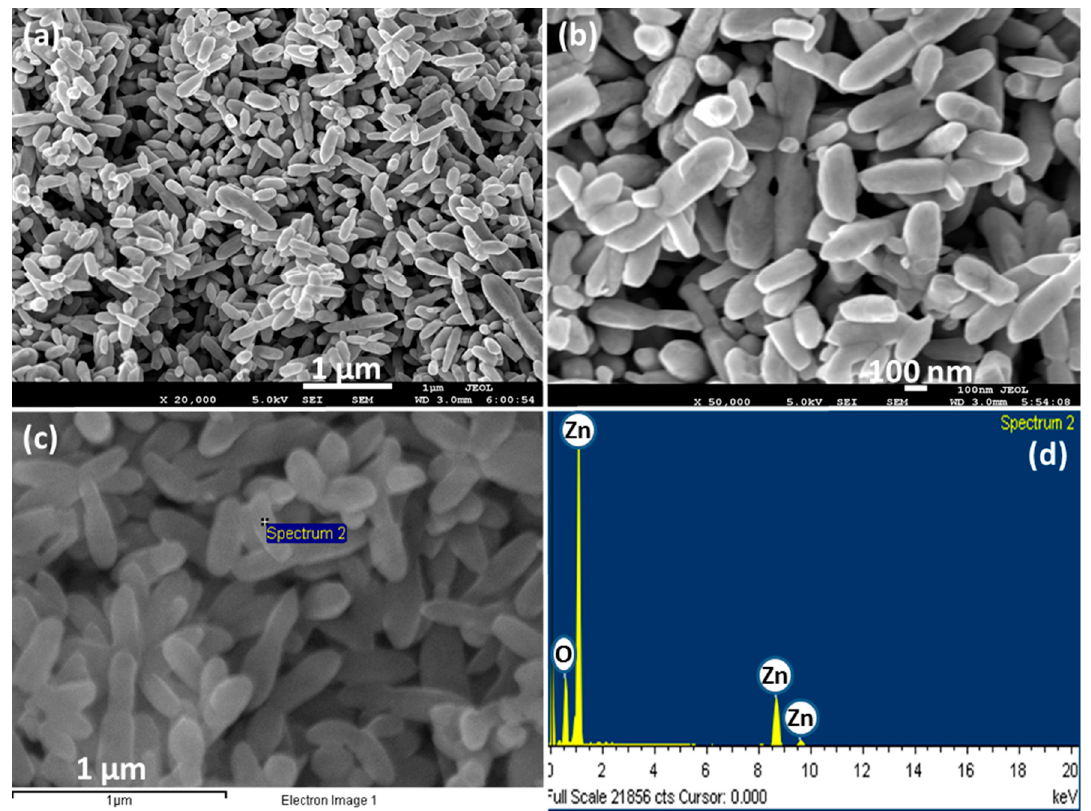
Figure 1. Typical ( a , b ) FESEM images; ( c ) EDS-SEM microscopic image and ( d ) EDS spectrum of the as-synthesized ZnO nanopeanuts.